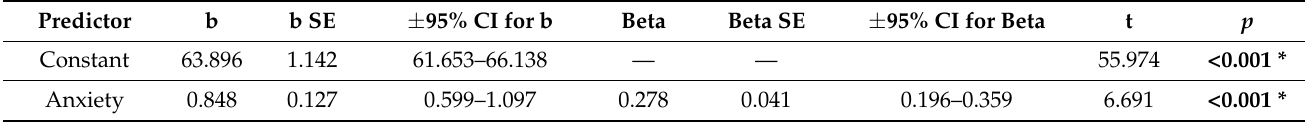
Table 3. Regression model of generalized aggression towards severity of anxiety. Predictor